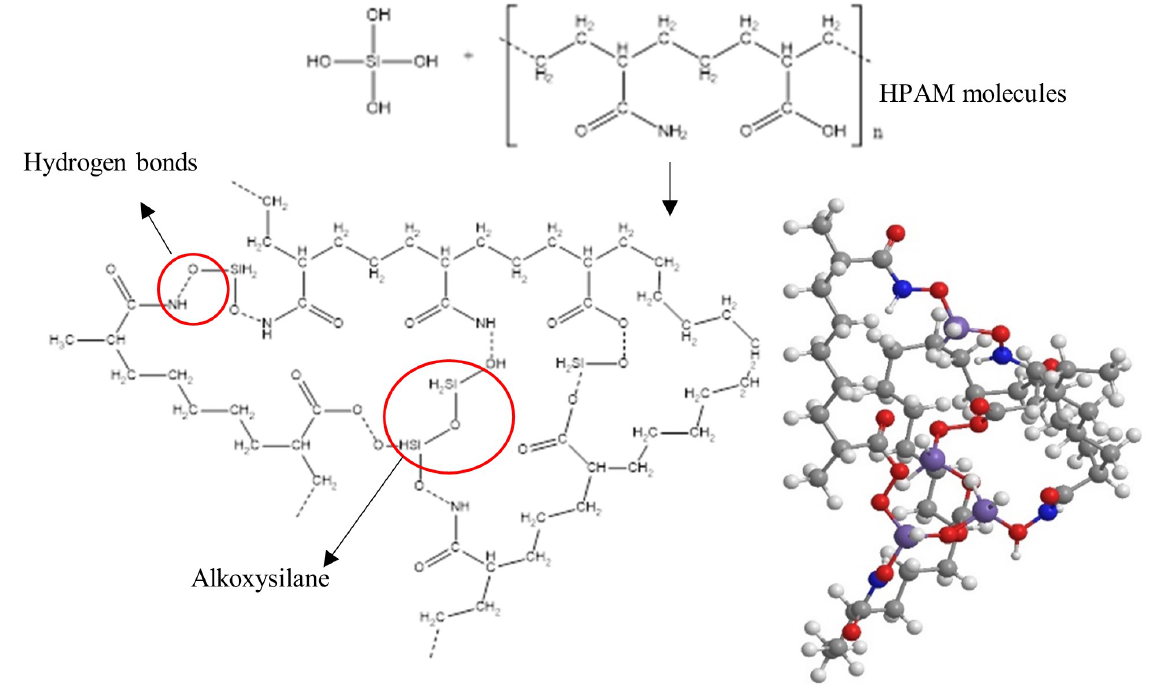
Fig. 6. Schematic diagram illustrating the formation of hydrogen bond and alkoxysilane between HPAM molecules. of Si-O-H, the hydroxyl on the silica surface allows the formation of hydrogen bonds with the amide group from HPAM, forming either SiO-H-N-H or SiO-H-O-CNH 2 . All the formed bonds contributed to the enhanced shear vis- cosity of HPAM-SiO2 NPs as clearly depicted in Fig.